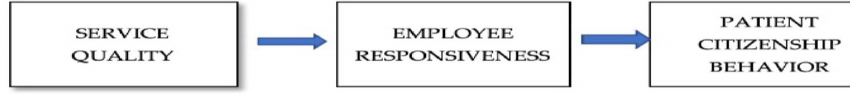
Figure 4. Mediating Effect of Employee Responsiveness. Figure 3. Mediating Effect of Patient Loyalty.